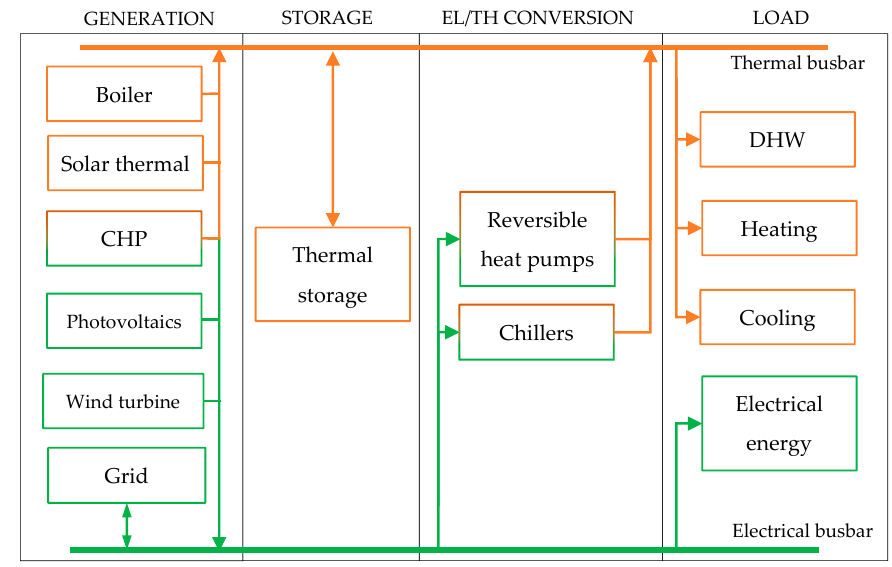
F igure 1. Schematic of the energy system. Figure 1. Schematic of the energy